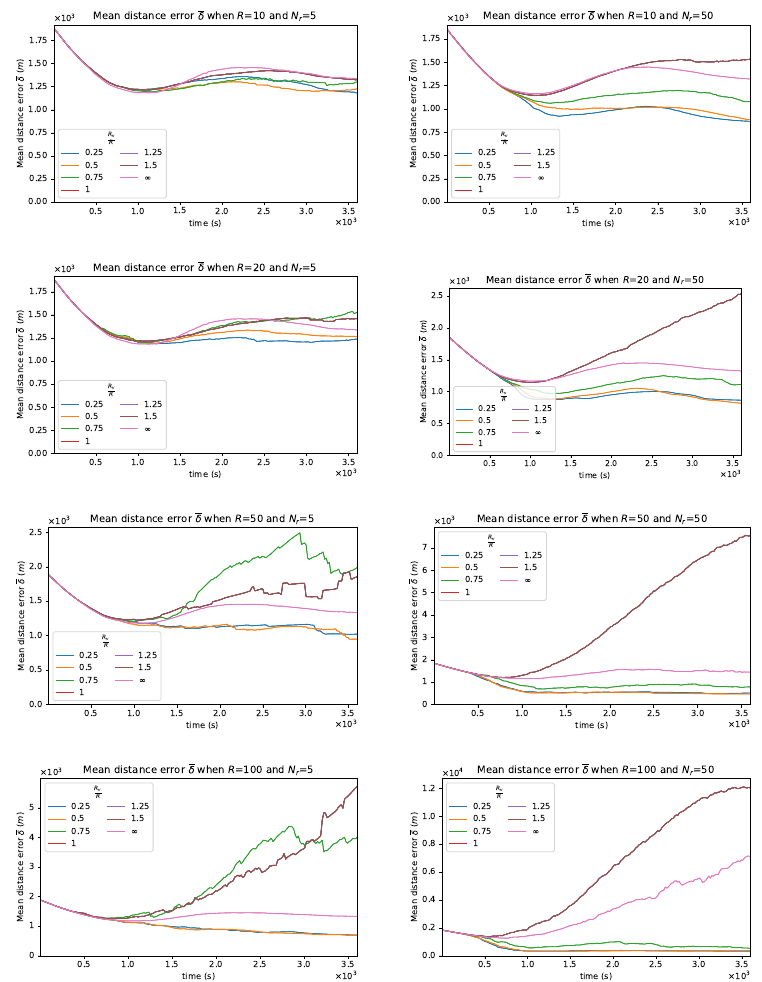
Figure 6. System performance measured as distance error for increasing communication range R ( top to bottom ) and different count of explorers N r (5 in the left column , 50 in the right column ). Implementations that generate virtual devices outperform the base implementation consistently, as far as virtual devices are generated densely enough. In most scenarios, setting R v = R 2 achieves a consistently good result. When R v is larger than R , the system performance degrades very quickly, mostly due to insufficient coverage, which, with few explorers, also causes erratic